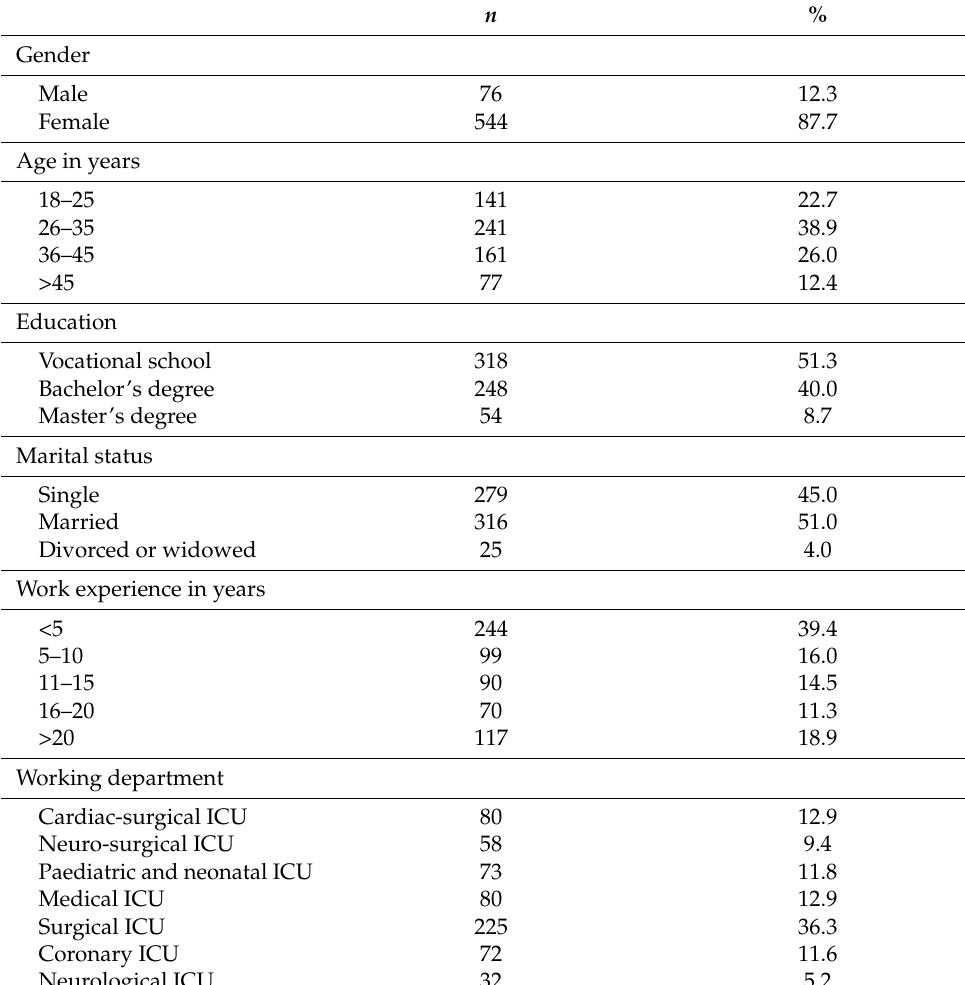
Table 1. Demographic characteristics of the sample ( n =